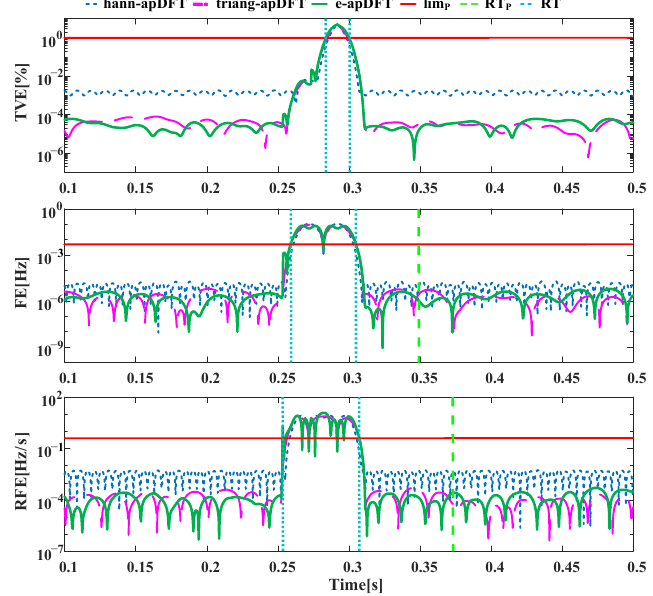
Figure 12. Amplitude ramp test.